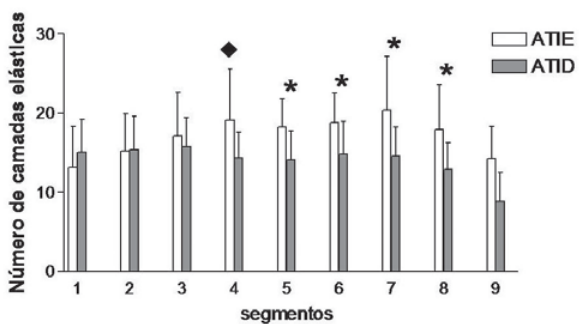
Fig. 6 – Houve diferença estatisticamente significativa no número de camadas elásticas, entre os segmentos de ATIs. A partir do segmento 4 até o segmento 8, foi encontrado maior número de fibras elásticas em ATI esquerda do que em ATI direita ( ♦ diferença significativa entre ATIE e ATID, p<0,003; * diferença significativa entre ATIE e ATID, p<0,0001)